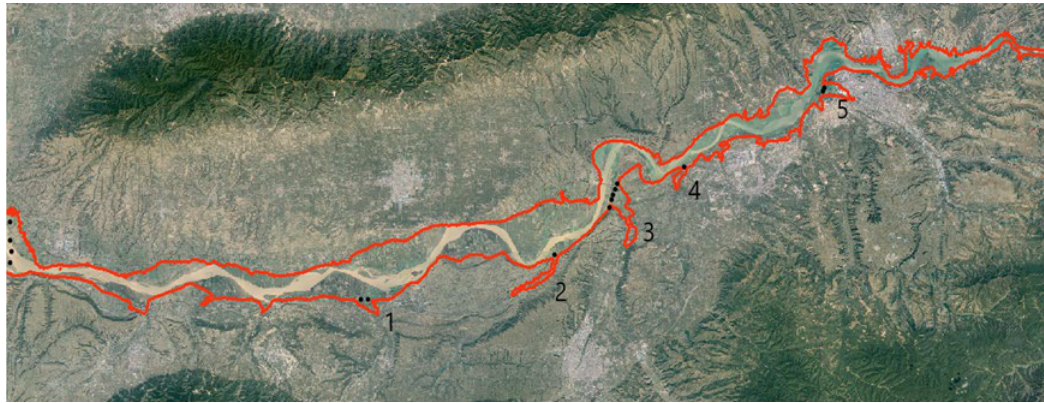
Figure 4. The 330 m elevation line of Sanmenxia Reservoir area.